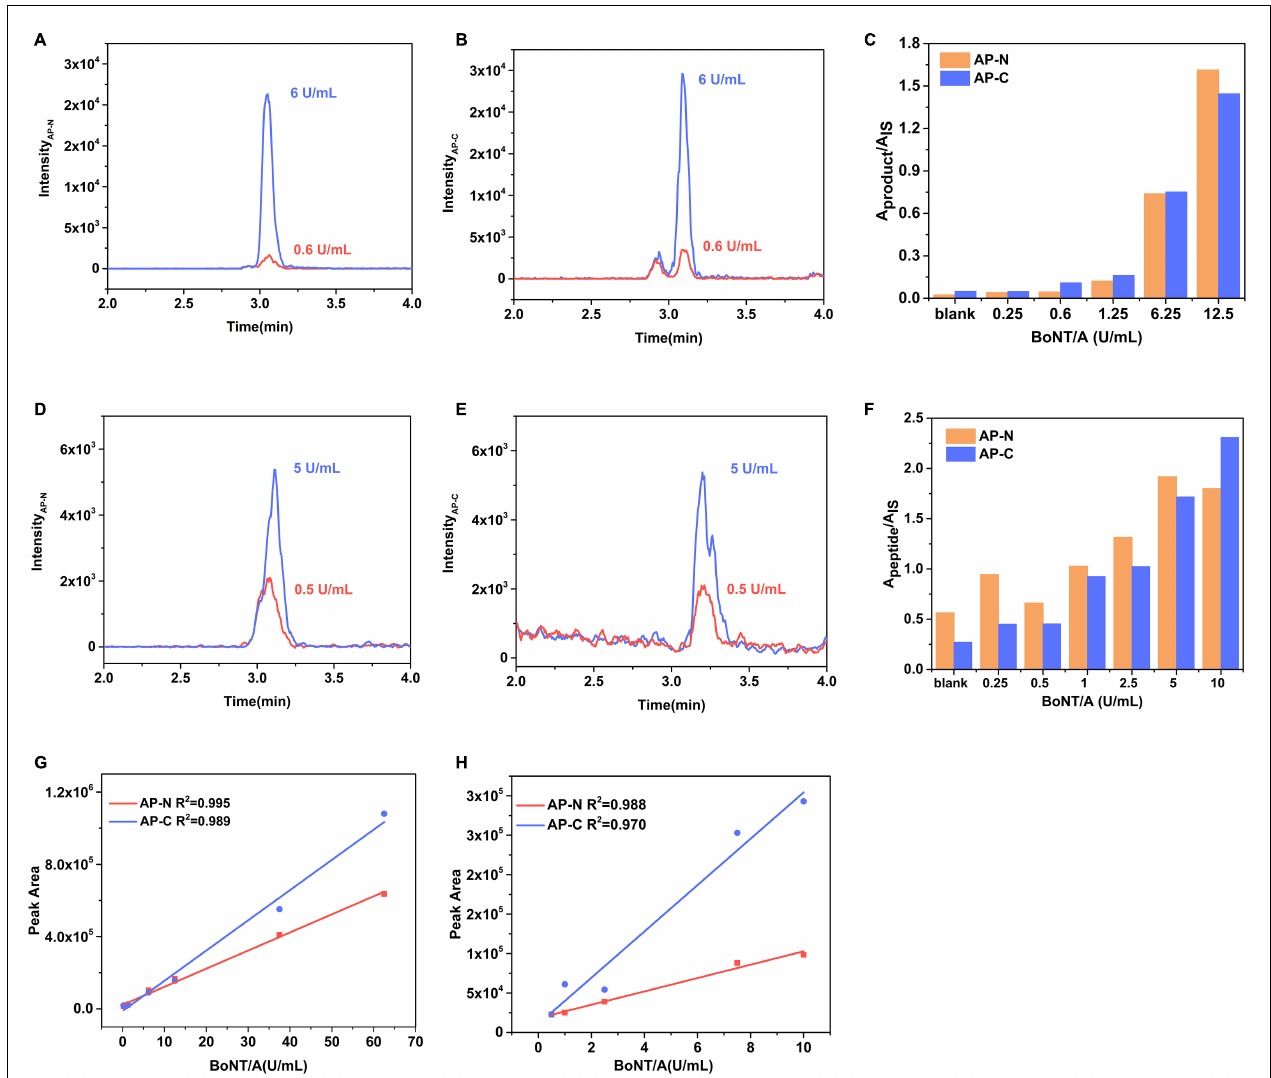
FIGURE 2 | Performance of the Endopep-MS Method in PBS and serum. LC-MS/MS (MRM) peak intensities for (A) N-terminal cleavage products (AP-N) obtained at 6 U/ml BoNT/A and LOD (0.6 U/ml BoNT/A), (B) C-terminal cleavage products (AP-C) obtained at 6 U/ml BoNT/A and LOD in PBS. (C) Comparison of cleavage products of AP from different concentrations of BoNT/A spiked in PBS. LC-MS/MS (MRM) peak intensities for (D) AP-N obtained at 5 U/ml BoNT/A and LOD (0.5 U/ml BoNT/A), (E) AP-C obtained at 5 U/ml BoNT/A and LOD in serum. (F) Comparison of cleavage products of AP from different concentrations of BoNT/A spiked in serum. A calibration curve of BoNT/A spiked in panel (G) PBS and panel (H)